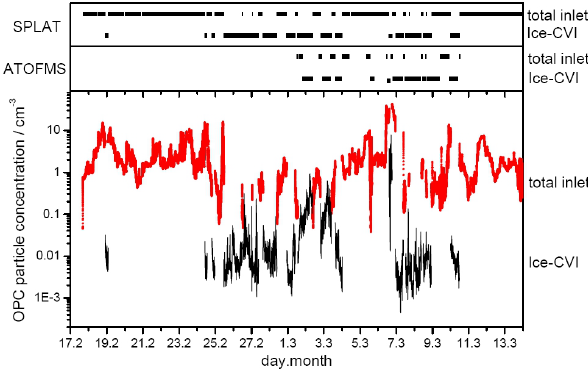
Fig. 1. SPLAT (upper panel) and ATOFMS (middle panel) instru- ments connected to the total inlet and Ice-CVI. For the measure- ments of 6 March the CVI was operated in droplet mode with the pre-impactor removed. Lower panel shows particle concentrations measured with an OPC. Mean particle concentrations with diame- ters > 300nm were 2.6particlescm − 3 at the total inlet (red trace) and 0.03particlescm − 3 at the Ice-CVI (black trace, corrected for Ice-CVI enhancement